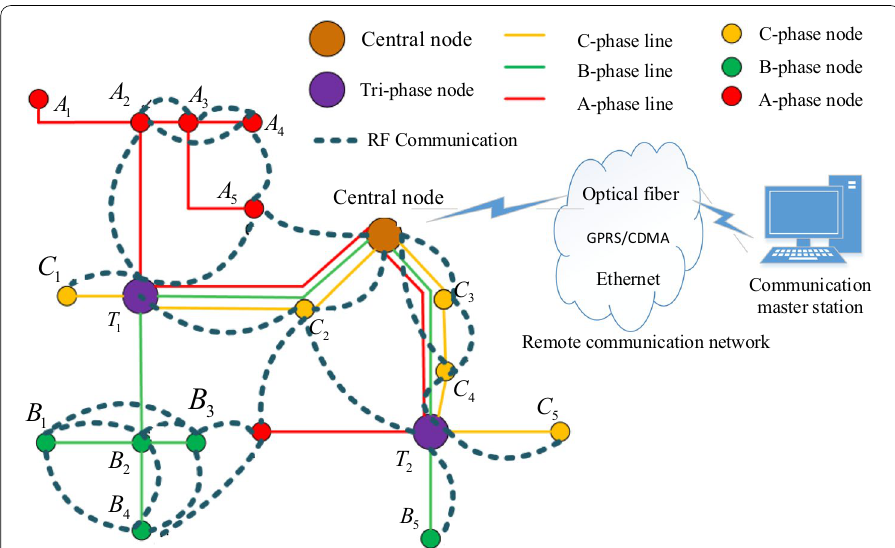
Fig. 1 Topology of dual-mode heterogeneous field